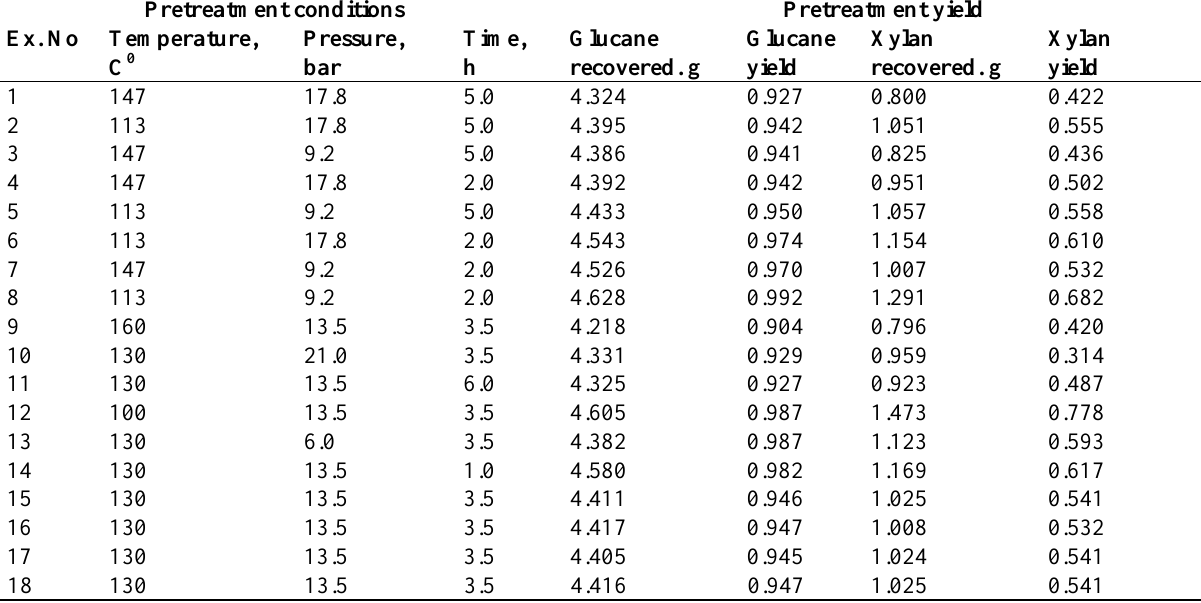
Pretreatment yield of glucan and xylan with pretreatment conditions .